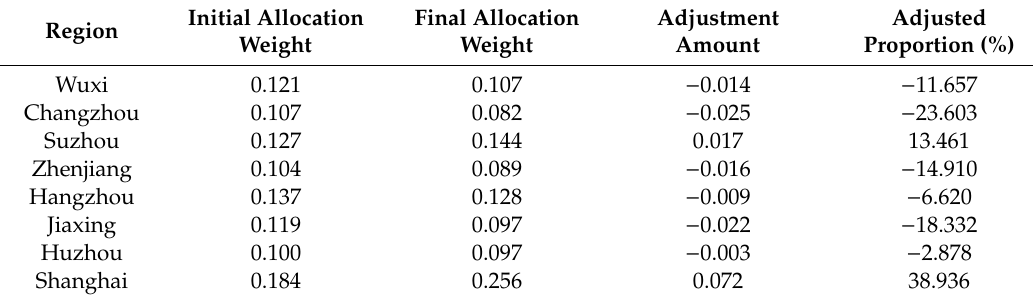
Table 9. Allocation results of flood drainage rights.